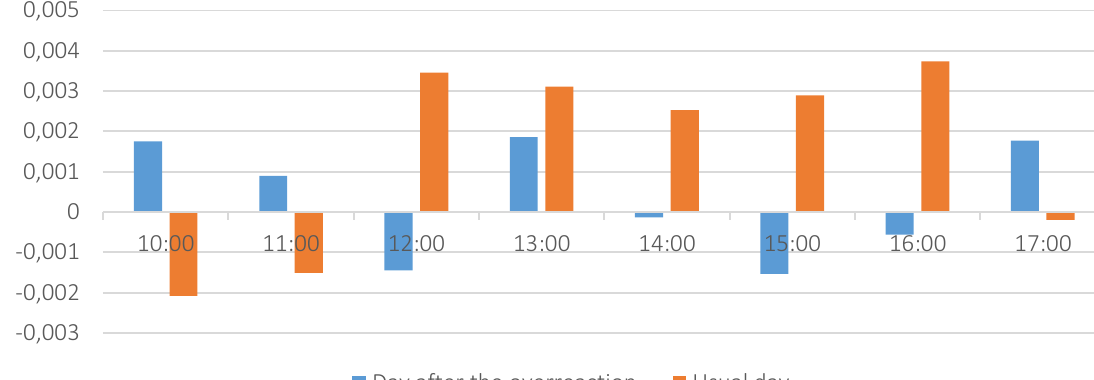
Figure 4. Average hourly returns on the day after the overreaction and normal days: case of positive overreactions,